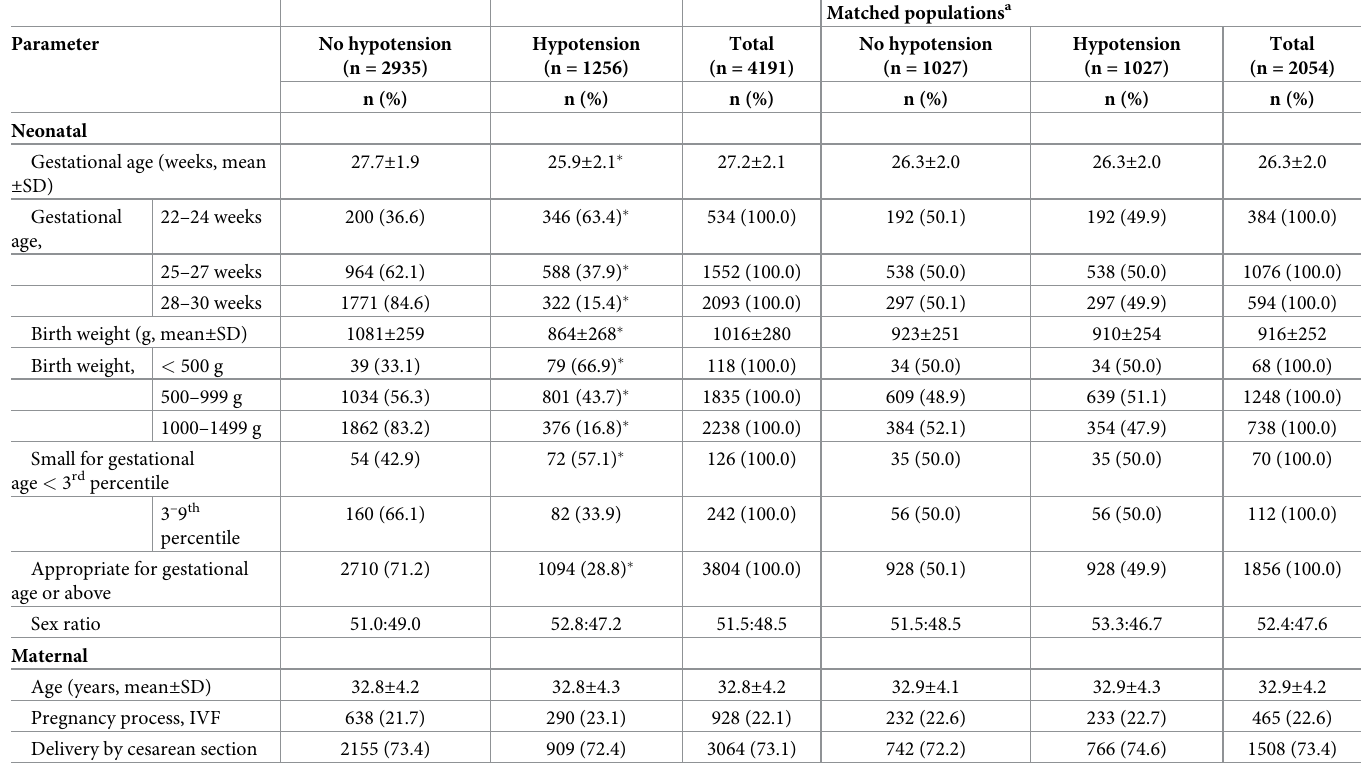
Matched populations